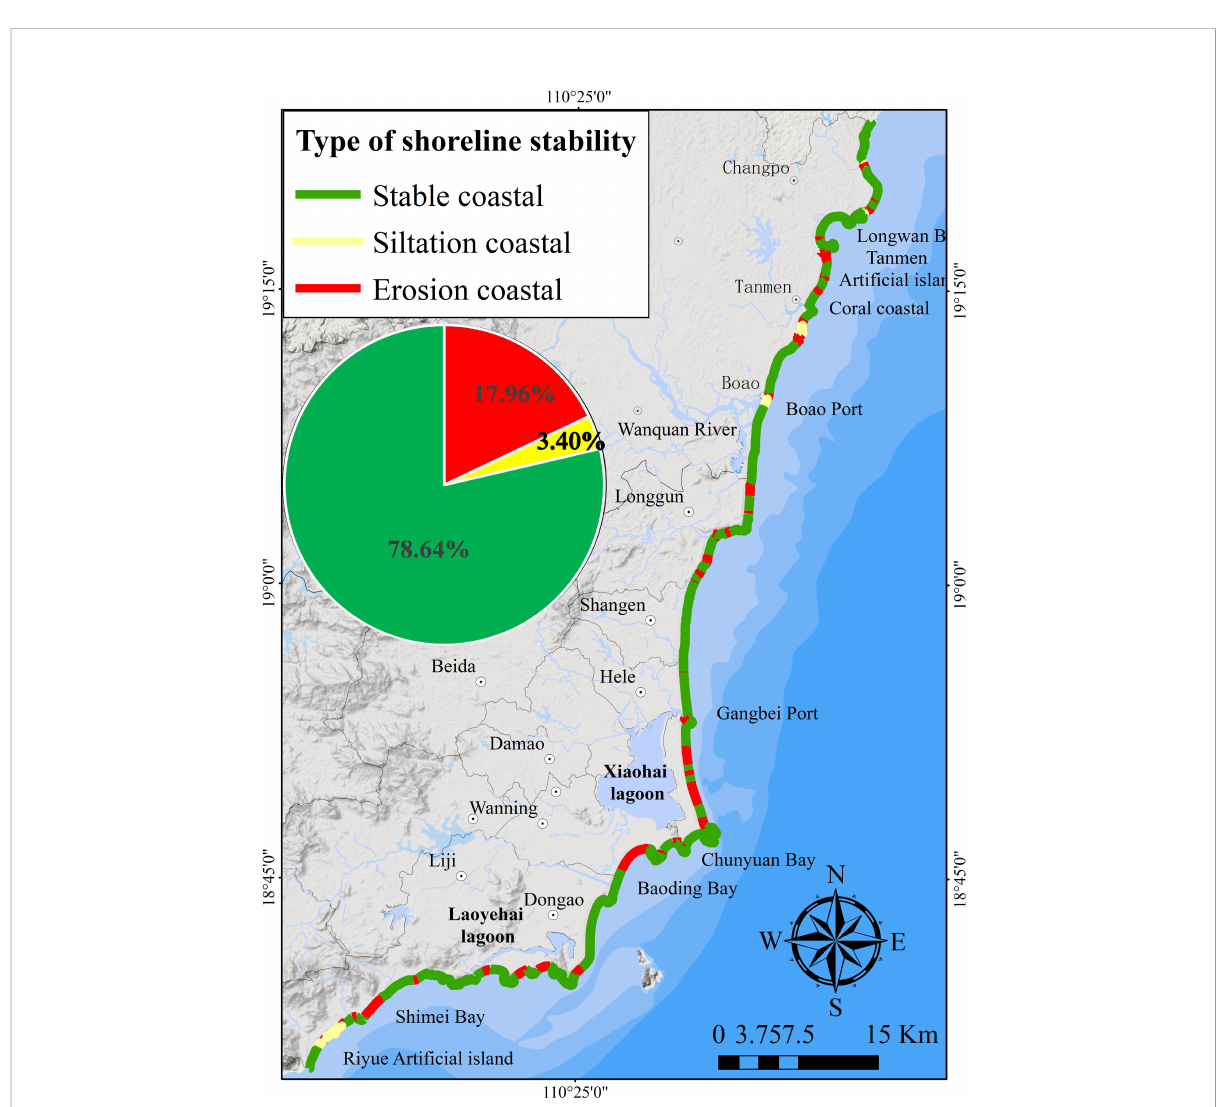
FIGURE 4 Spatial distribution map of coastal erosion and deposition in Qionghai-Wanning in